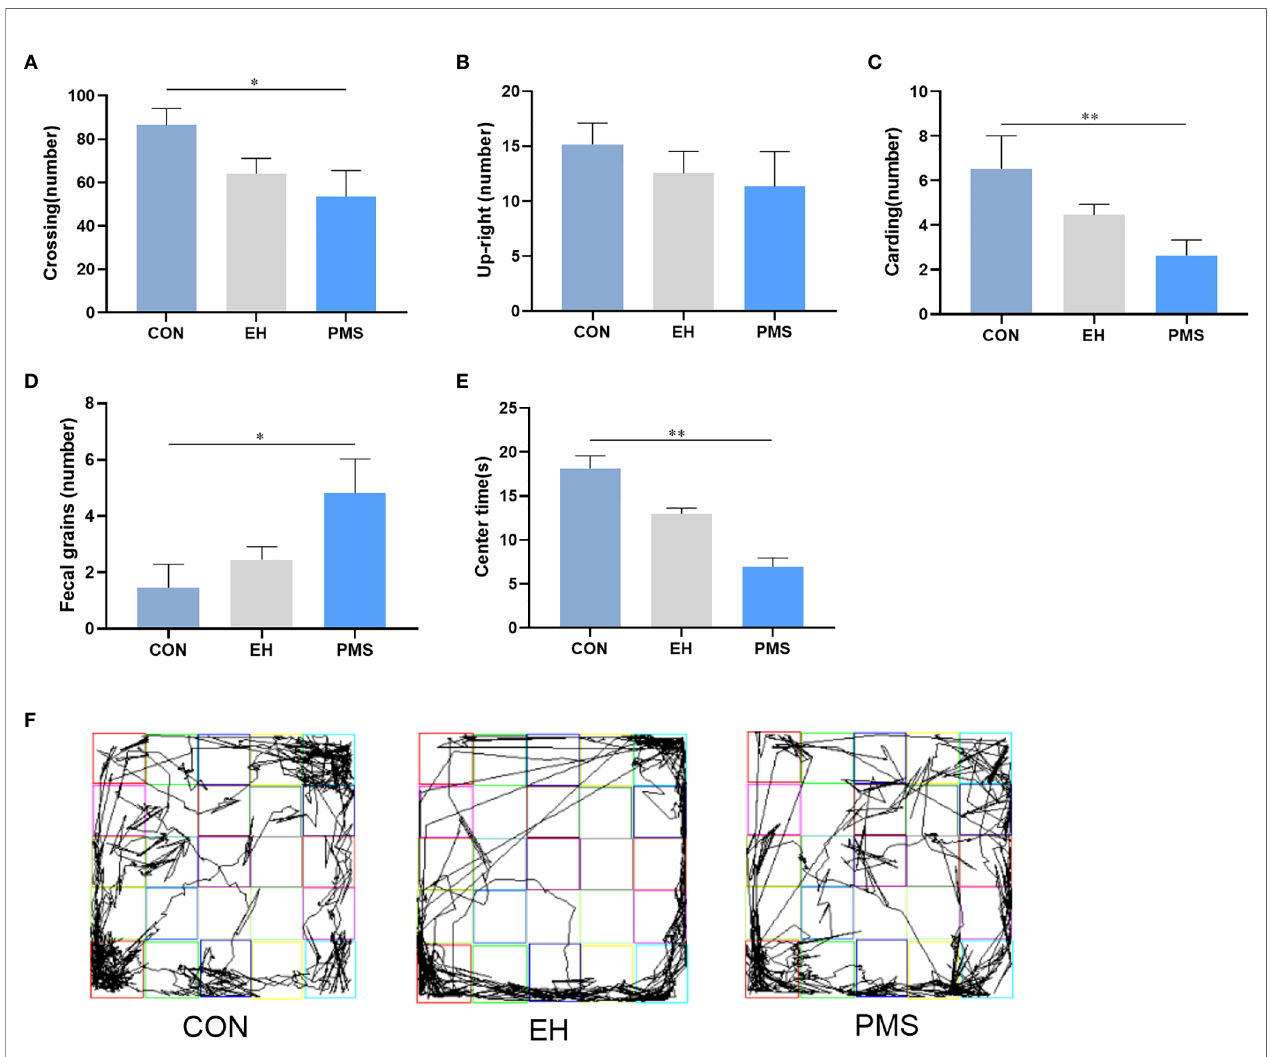
FIGURE 3 | In the open fi eld, PMS group had reduced number in upright, carding and fecal grains compared with other groups . (A) : the number of crossings in the OFT. (B): the number of upright in the OFT. (C): the number of carding in the OFT. (D): the number of fecal gains in the OFT. (E): the time at the center state in the OFT. Values are expressed as the mean ± SEM (n= 11 rats per group). Representative diagrams of the pathways in the OFT from each group, and (F) showed the rats ’ mobile trajectory Figs in CON, EH and PMS group. *p < 0.05, **p <